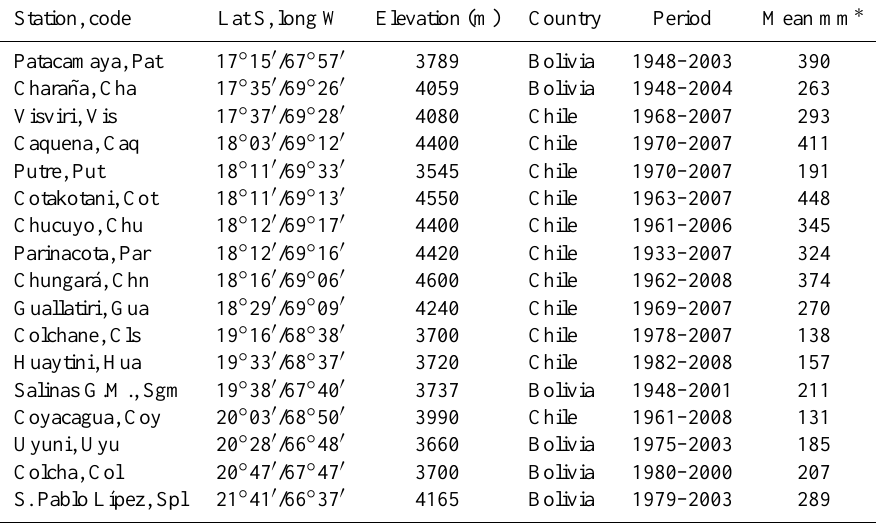
Table 1. Precipitation stations used to developed a regional series of November–October rainfall variations in the Altiplano. Station, code